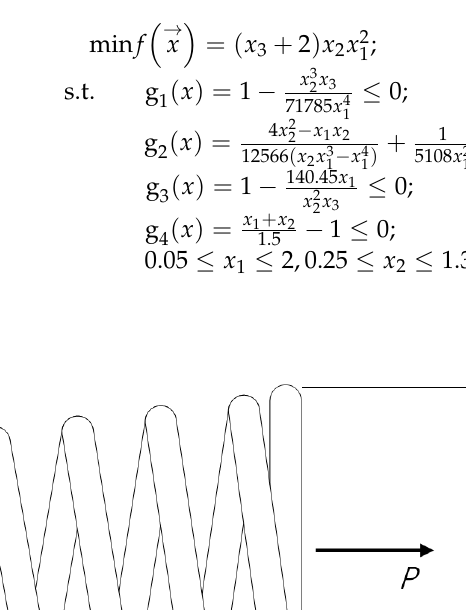
Table 10. Comparison results of six algorithms in spring design problem.